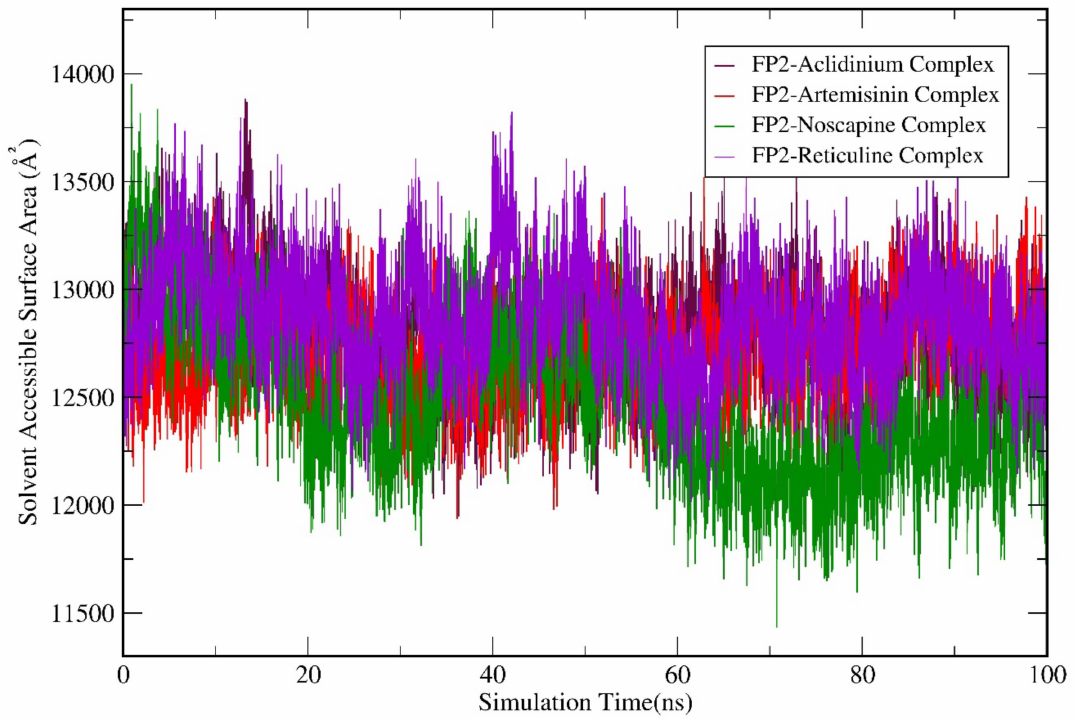
Figure 6. Molecular dynamics simulation (MDS) result analysis for FP-2-Artemisinin, FP-2 Noscapine, FP-2 Reticuline, and FP-2 Aclidinium complexes representing SASA (Solvent-accessible surface